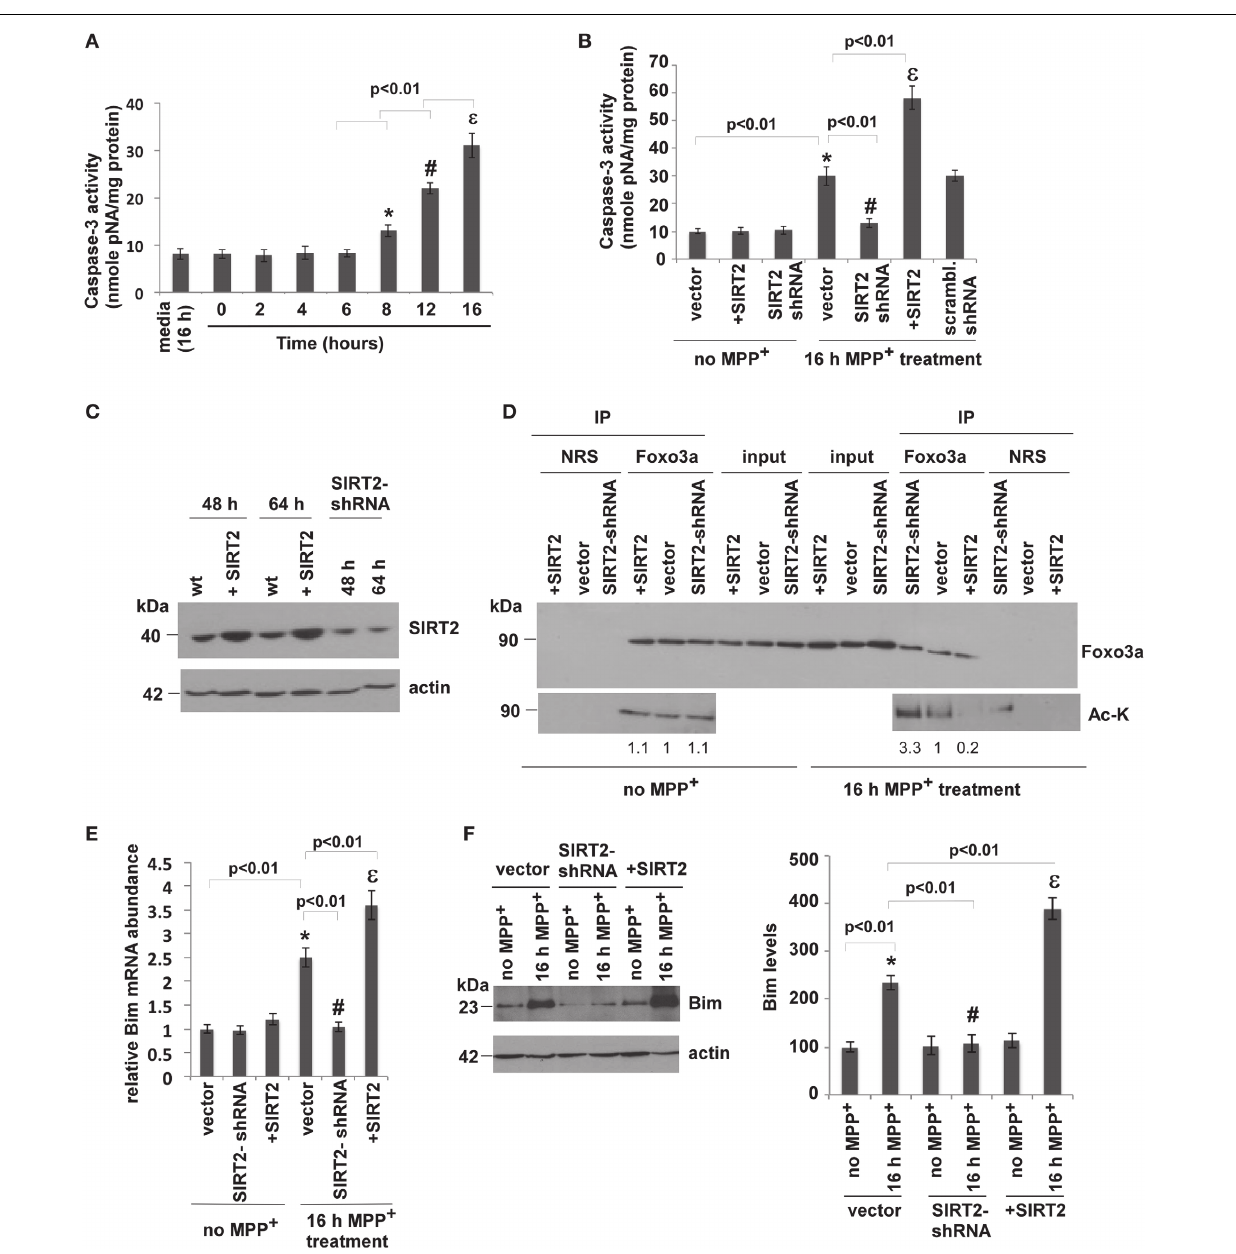
FIGURE 2 | SIRT2 deacetylates Foxo3a, increases Bim levels and leads to apoptosis in MPP + -treated cells. (A) MPP + treatment increases caspase-3 activity in SH-SY5Y (neuroblastoma) cells. Caspase-3 activity was determined from the supernatants of SH-SY5Y cell lysates after treatment with MPP + for the indicated times. Bars represent s.e.m of three independent experiments. Statistical analyses were carried out using Two-way ANOVA. ∗ p < 0 . 01, 8h vs. 0 h; # p < 0 . 01, 12h vs. 8h; ε p < 0 . 01, 16h vs. 12h. (B) Overexpression of SIRT2 increases and silencing SIRT2 decreases the caspase-3 activity that is elevated after MPP + treatment. The graph shows the caspase-3 activity in the supernatants of SH-SY5Y cell lysates where SIRT2 is overexpressed ( + SIRT2) or silenced (SIRT2-shRNA) without (no MPP + ) or with MPP + treatment for 16h. Bars represent s.e.m of three independent experiments. Statistical analyses were carried out using Two-Way ANOVA. ∗ p < 0 . 01, vector with MPP + vs. vector no MPP + ; # p < 0 . 01, SIRT2-shRNA with MPP + vs. vector with MPP + ; ε p < 0 . 01, + SIRT2 with MPP + vs. vector with MPP + . (C) Relative protein levels of SIRT2 are increased as a result of transfection